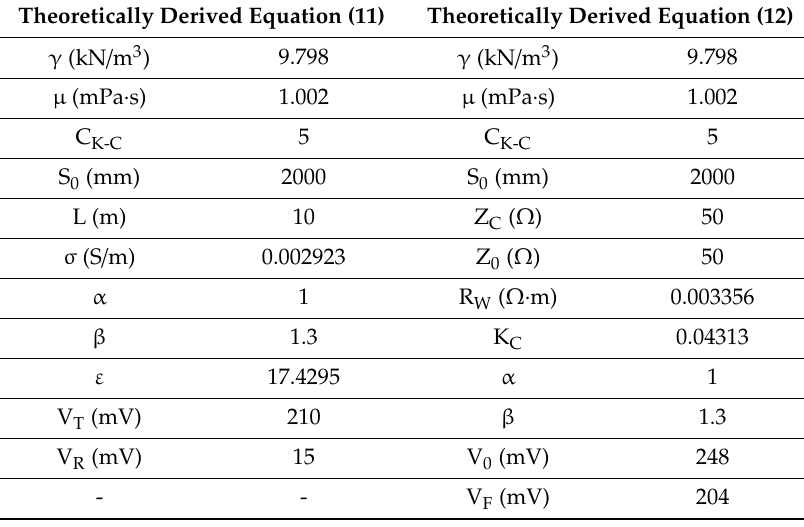
Table 2. The reference values for performing the sensitivity